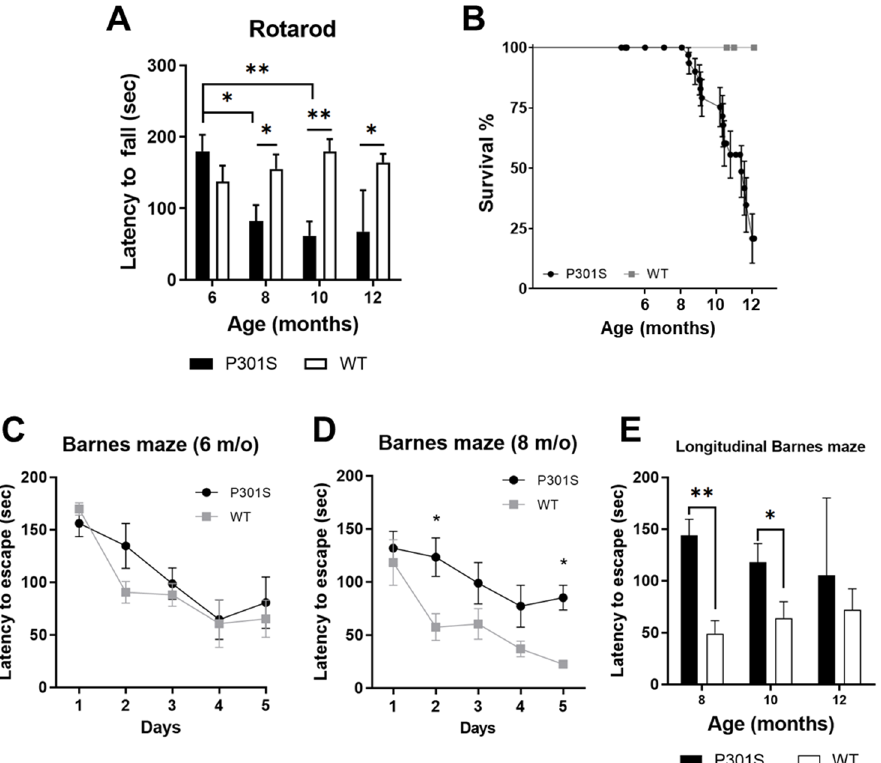
Figure 3. Longitudinal analysis of cognition in P301S and WT animals. ( A ) P301S mice exhibited significant motor impairments by 8 months of age that continued to 12 months of age compared to WT mice. ( B ) P301S mice demonstrated hindlimb paralysis that began at approximately 8.5 months and left about a 20% survival at 12 months of age compared to controls (Mantel–Cox, p < 0.0001). ( C ) Barnes maze testing at 6 months of age did not reveal any significant difference in the learning curve of the mice ( p > 0.05). ( D ) Barnes maze performance at 8 months of age, however, was significantly decreased in P301S mice as revealed by a repeated measures, two-way ANOVA ( p < 0.001) with post-hoc analysis. ( E ) At 8 and 10 months, the average primary latency on Barnes maze demonstrated that spatial recall was significantly impaired (* p < 0.05, ** p < 0.01, *** p < 0.001).